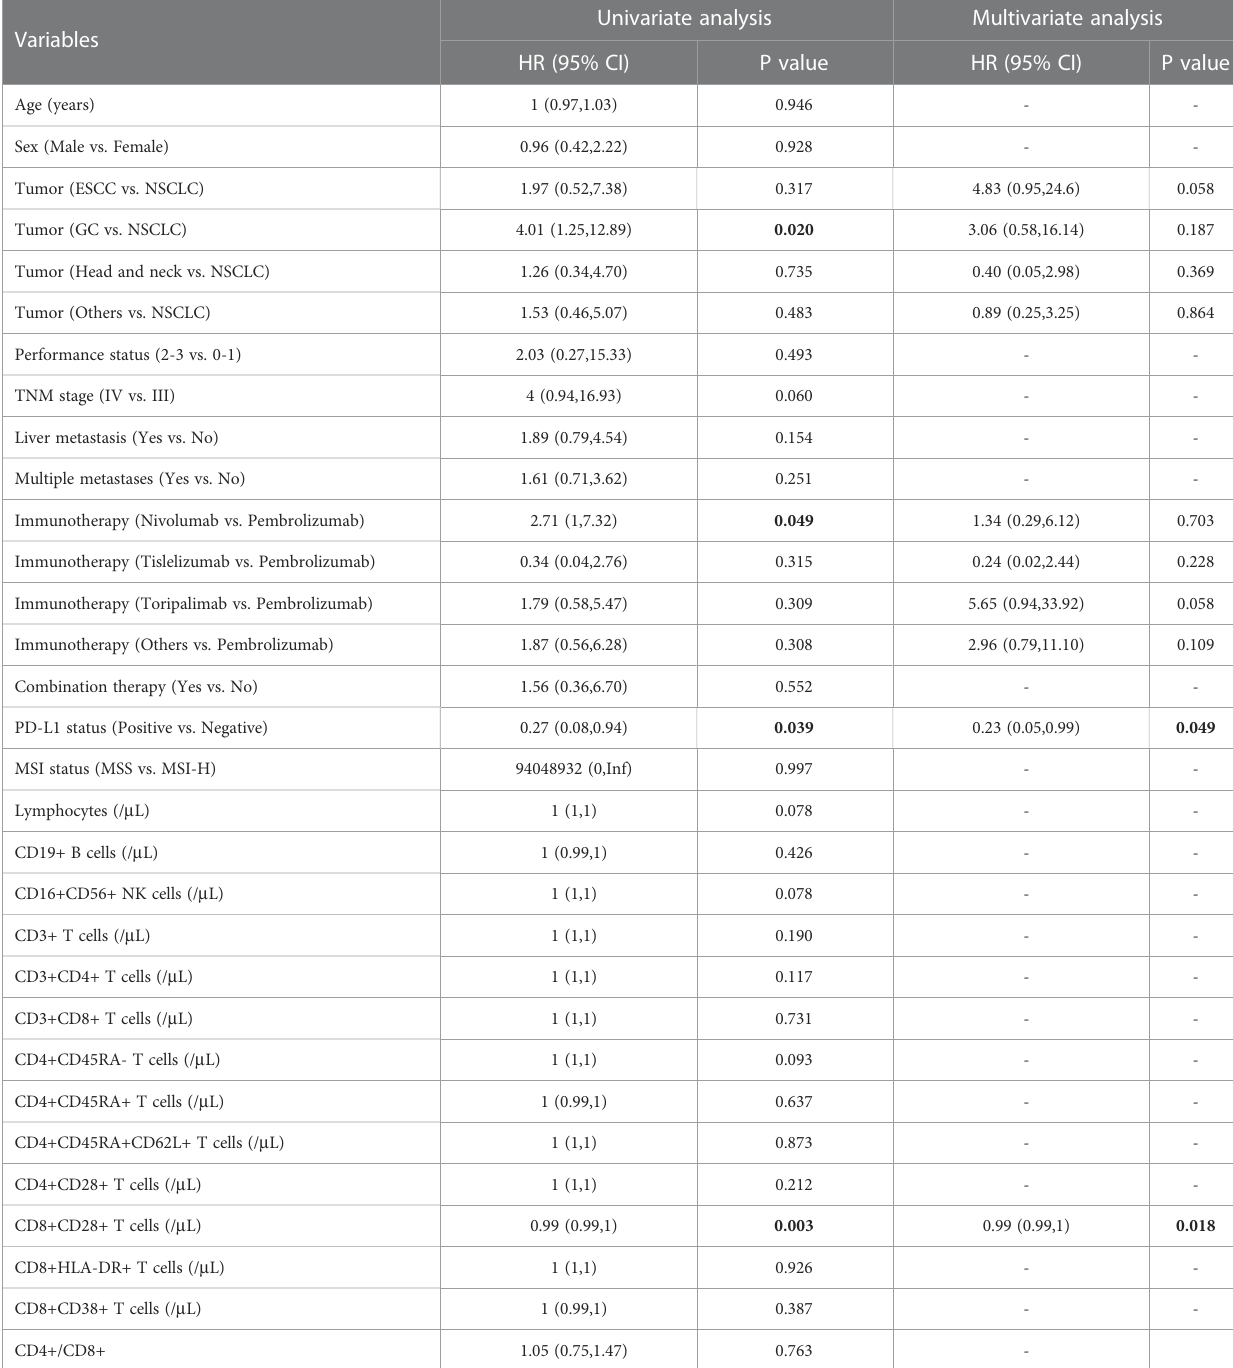
TABLE 4 Univariate and multivariate Cox analyses of factors for overall